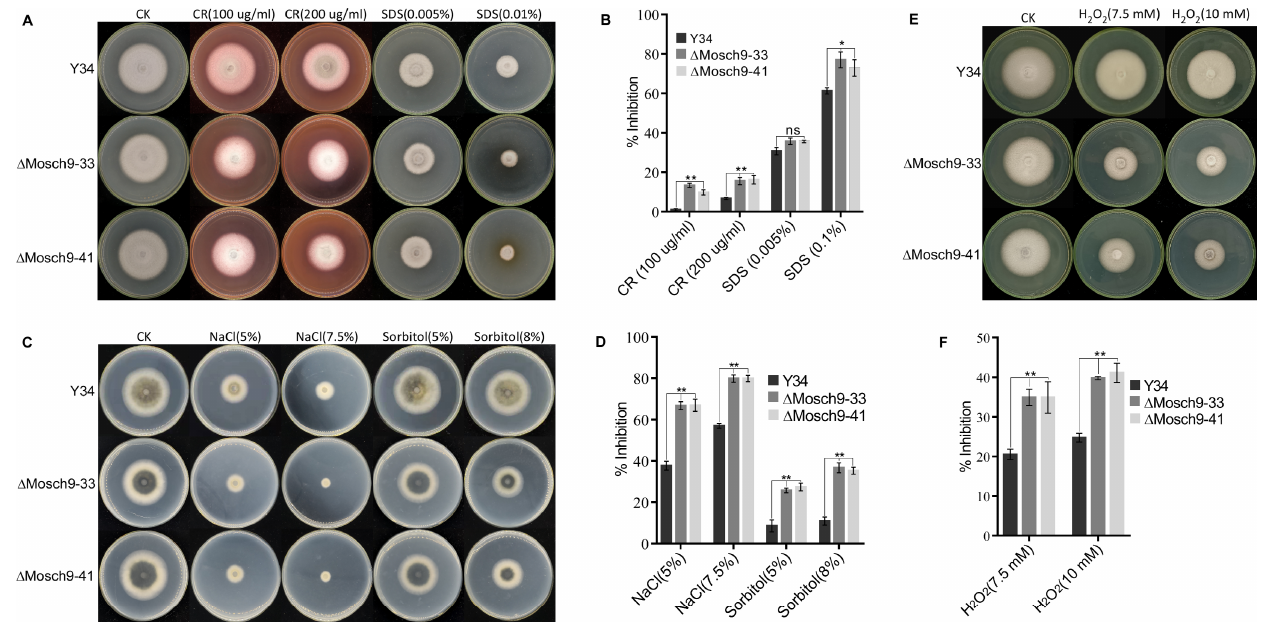
Figure 4. Contributions of MoSch9 to multiple environmental stress tolerance of Magnaporthe oryzae . ( A ) Depicts the average colony growth of ∆ MoSch9 strains and wild-type cultured on CM media supplemented with different concentrations of cell membrane stress-inducing osmolytes (CR and SDS) for 7 days. ( B ) Statistical depiction of the growth inhibition rate for ∆ MoSch9 strains, and wild type cultured on CR- and SDS-supplemented CM media for 7 days. ( C ) Showed the comparative colony growth of ∆ MoSch9 strains and wild-type cultured on CM media supplemented with different concentrations of osmotic stress-inducing chemicals (NaCl and sorbitol) for 7 days. ( D ) Statistical illustration of ∆ MoSch9 strains and wild type growth inhibition rate under NaCl and sorbitol stress. ( E ) Depicts the average hyphal growth of respective strains cultured on CM media supplemented with different concentrations of oxidative stress-inducing osmolyte, H2O2, for 7 days. ( F ) Statistical depiction of the growth inhibition rate for ∆ MoSch9 strains and wild type under hydrogen peroxide (H2O2) stress. Inhibition rate was obtained using the formula: (Inhibition rate = (untreated strain diameter − treated strain diameter)/(diameter of untreated strain × 100%)). Error bars indicate the means ± SD calculated from three independent technical replicates in which triplicate biological samples for each strain were examined in each experiment. (ns), (*), and (**) represent significant difference with p > 0.05, p < 0.05 and p < 0.01, respectively using t